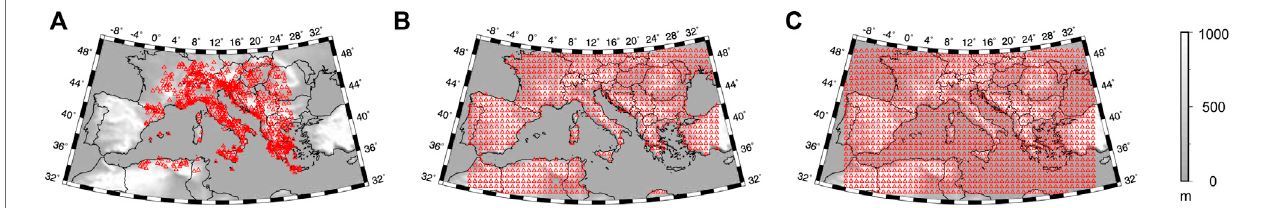
FIGURE 2 | Plot of the real land (as in Rappisi et al., 2022) (A) , ideal land (B) and ideal marine and land (C) station distribution.